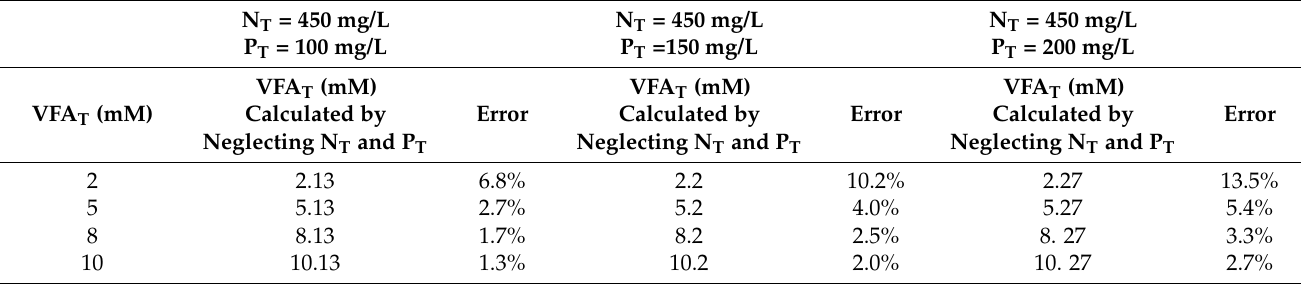
Table 1. The error induced in VFA T calculation (Equation (5)) by neglecting the alkalinity components related to the ammonia and orthophosphate weak-acid